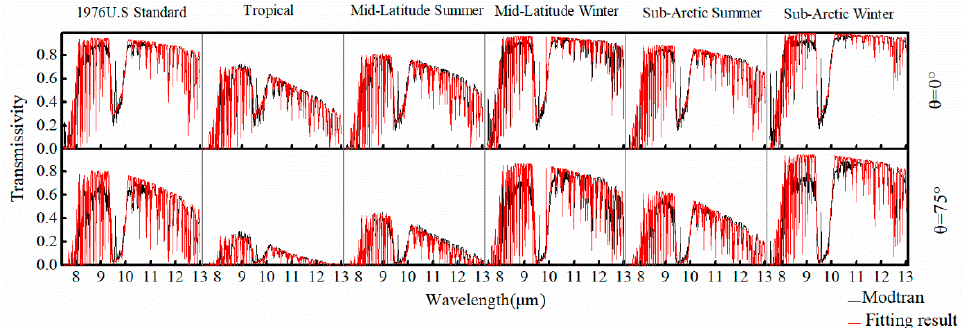
Figure 6. Atmospheric transmittance results of two sensor angles compared with Modtran results.